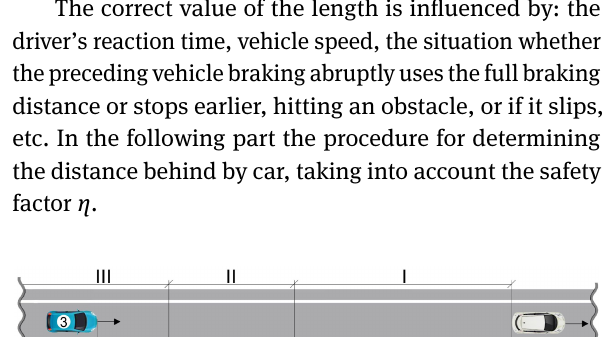
of the following car will be shifted in phase by the value as above, so that there is no collision or accident.